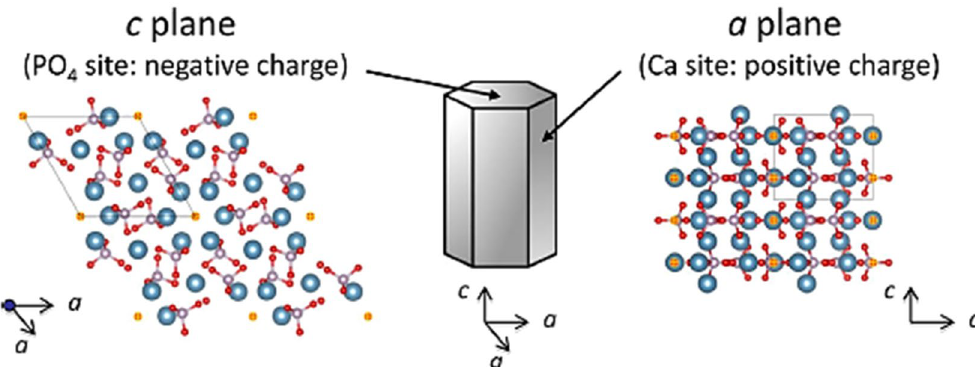
Figure 9. Schematic illustration of hydroxyapatite (HA) crystal structure consisting of positively charged a plane and negatively charged c plane. The blue, white, red, and yellow spheres represent Ca, P, O, and OH, respectively. Reprinted from “Synthesis and modification of apatite nanoparticles for use in dental and medical applications” by Okada, M. & Matsumoto, T. Jpn. Dent. Sci. Rev. 51 , p. 87 (2015). Copyright 2015 with permission from